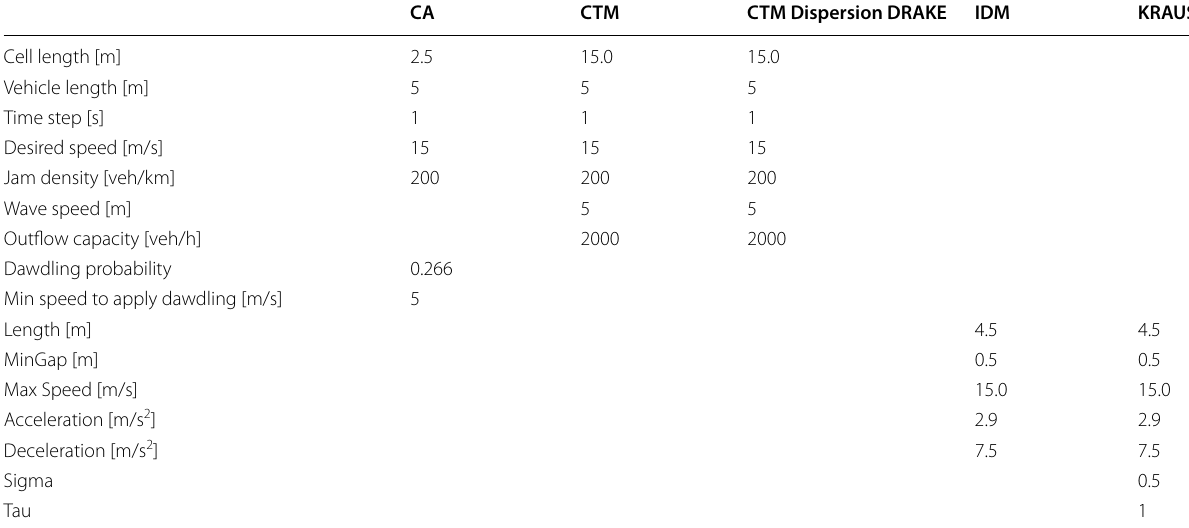
Table 1 Input of the traffic flow